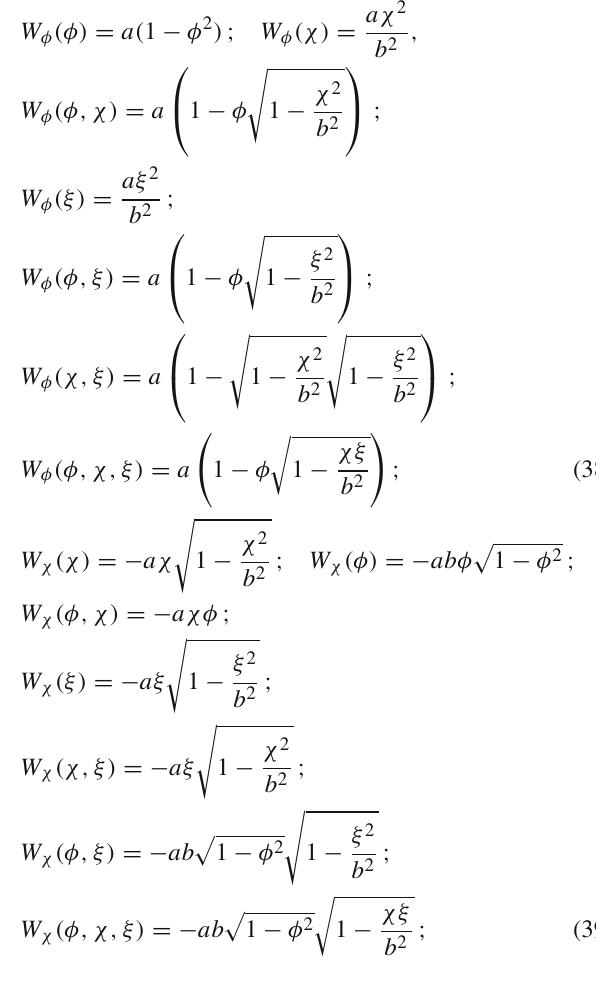
a 14 W φξ (ξ) + a 15 W φξ (φ, ξ) + a 16 W φξ (χ,